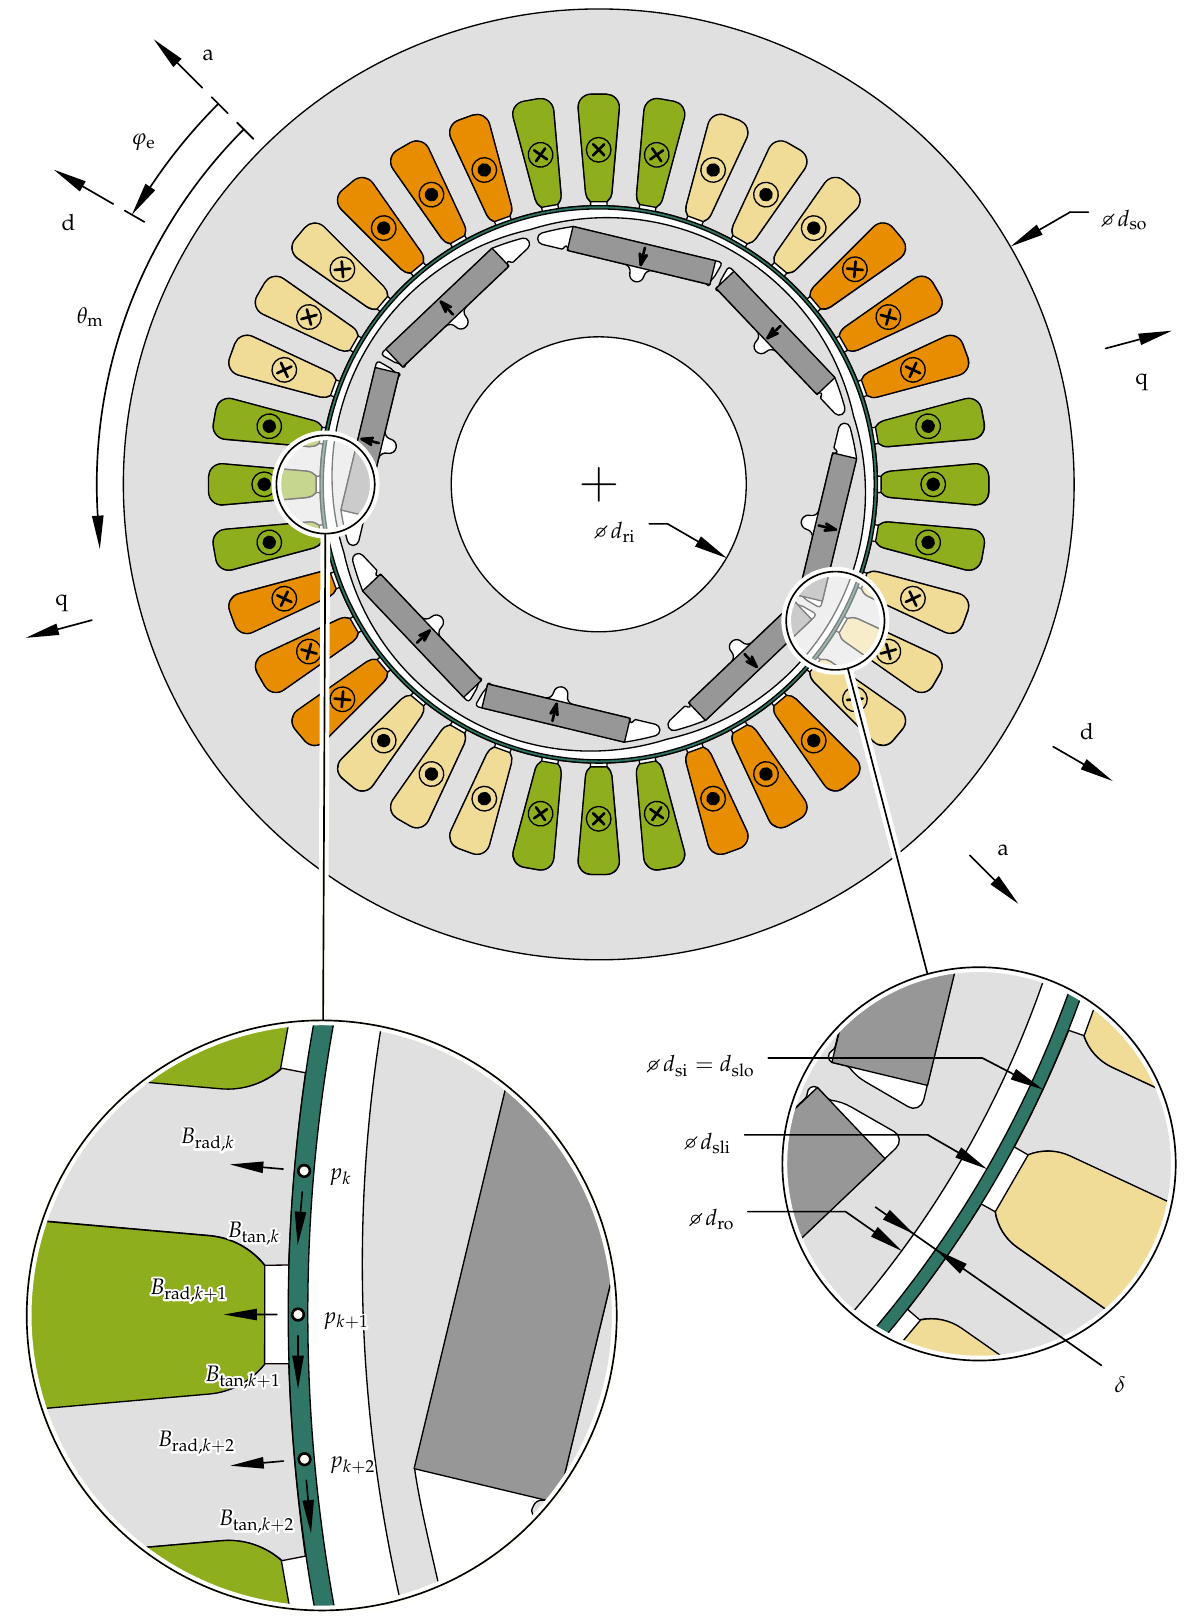
Figure 1. The radial cross section of the observed machine with key parameters and an example of evaluation points at the mid radius of the